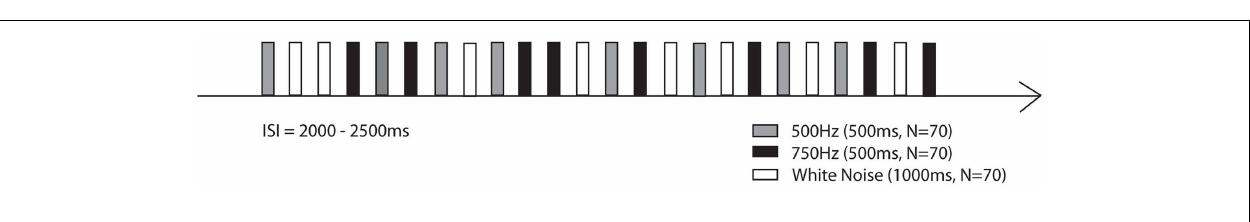
FIGURE 1 | Stimulation paradigm of the first part of the study (Tuebingen)